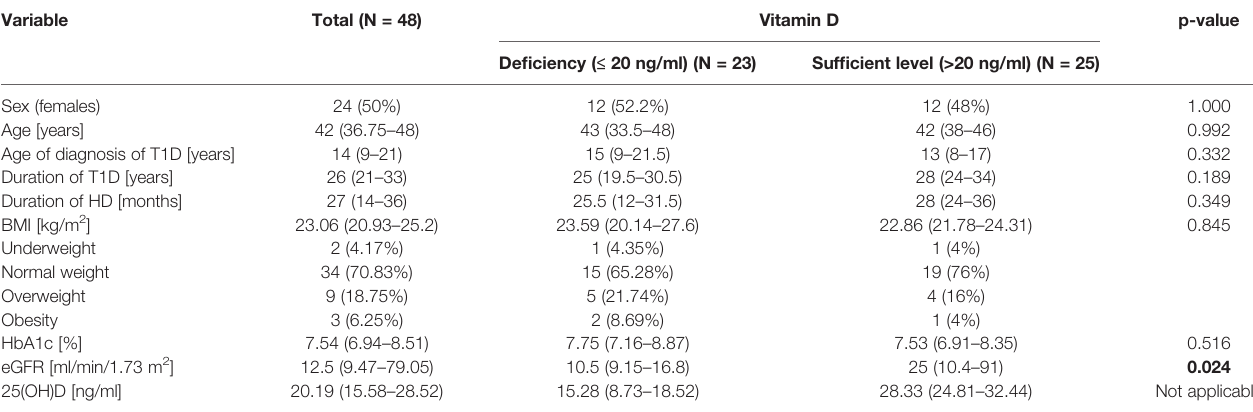
TABLE 1 | Baseline characteristics of the study group divided into subgroups according to 25(OH)D